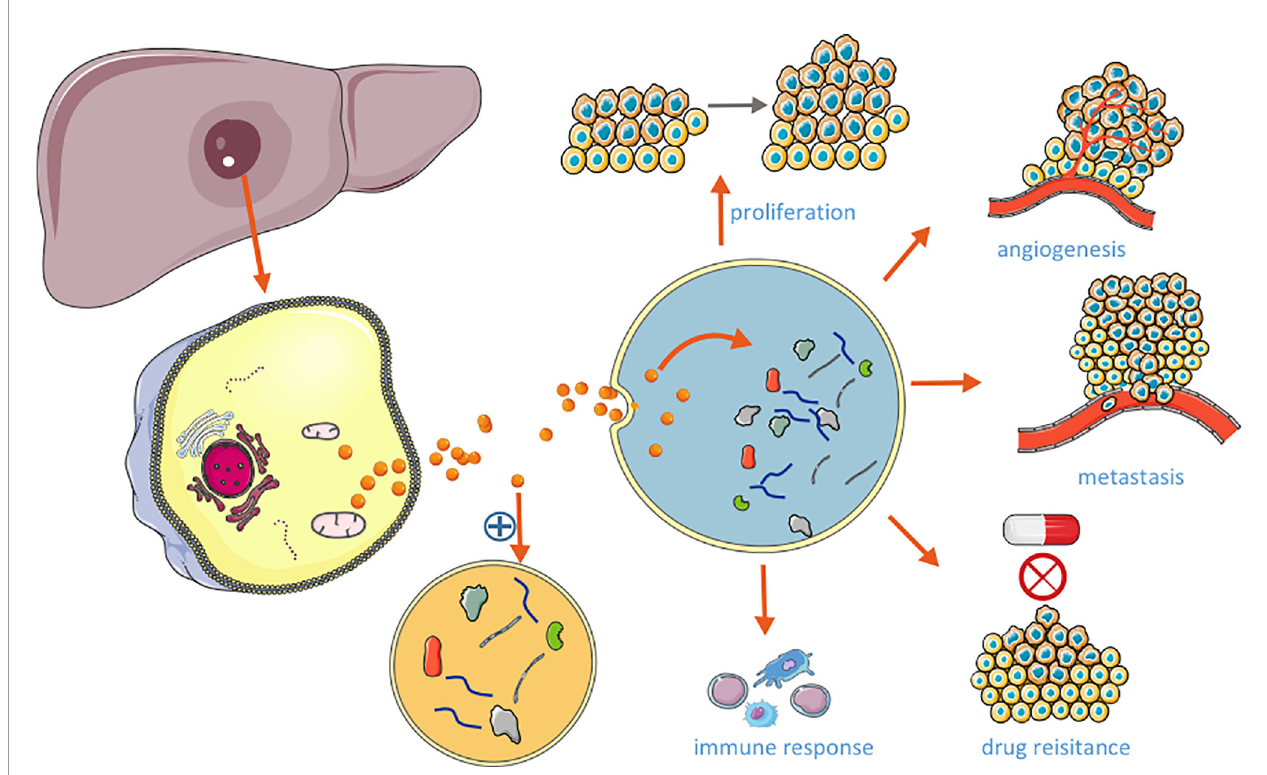
FIGURE 1 | Role of HCC-derived exosomes in